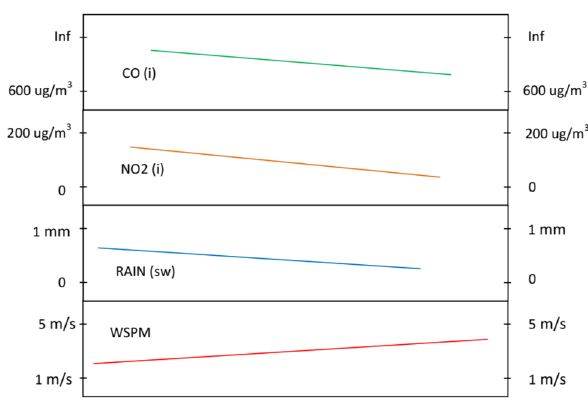
Fig. 4 One of the frequent proto-patterns registered in Dongsi